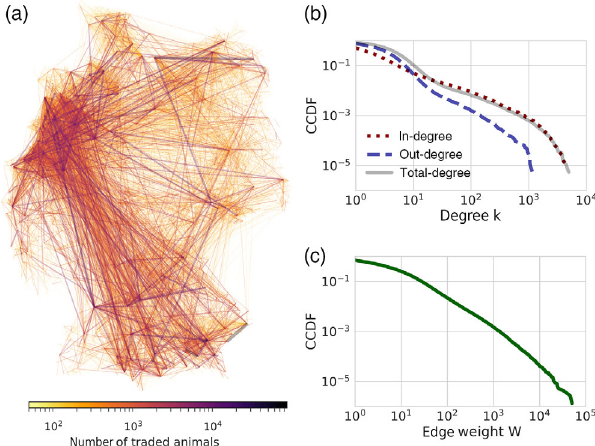
FIG. 10. Degree and weight analysis of cattle trade in the year 2010. Trade data are aggregated from 2010-01-01 to 2010-12-31. (a) Visualization of edges using geolocation with at least 50 animals traded along each link. The color and edge width indicate the aggregated edge weight. (b) Complementary cumulative distribution function (CCDF) of in, out, and total degree.